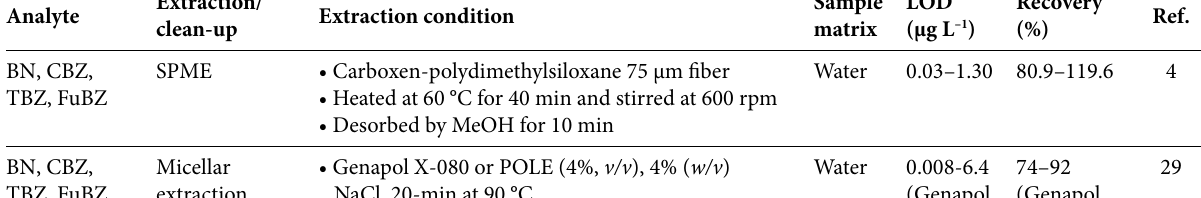
Table 4: Comparison of the HPLC technique with different preconcentration methods for the determination of benzimidazole fungicides in various sample matrices Analyte